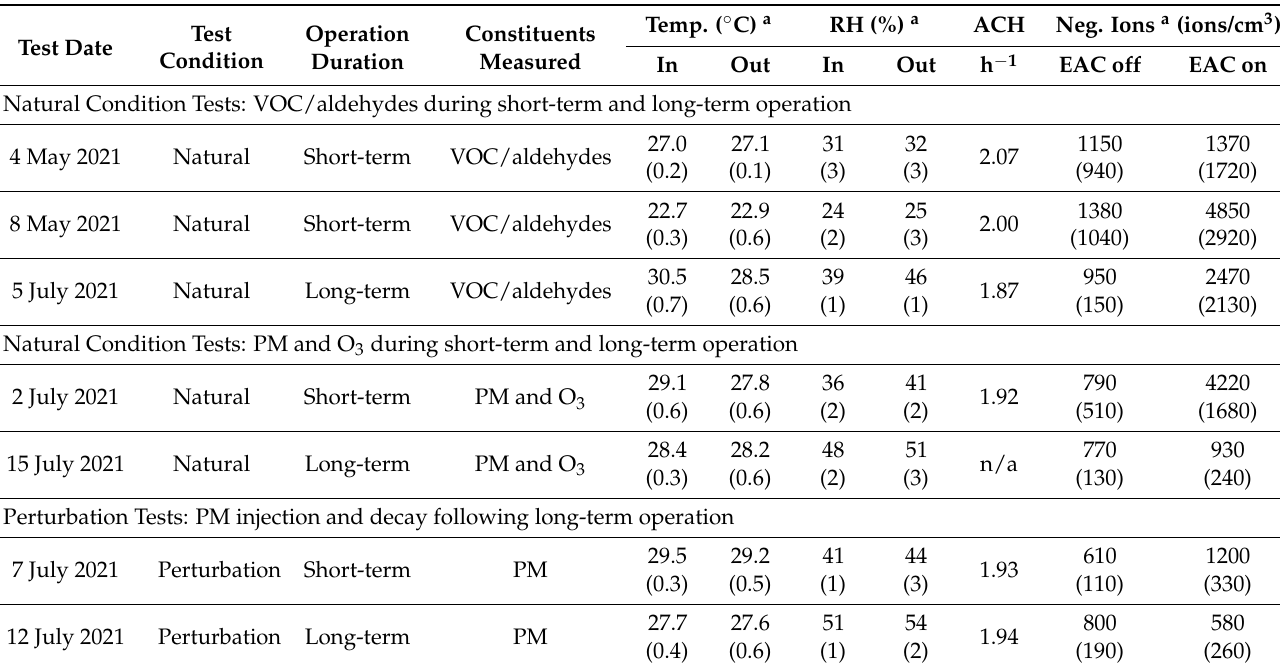
Table 2. Summary of chamber tests